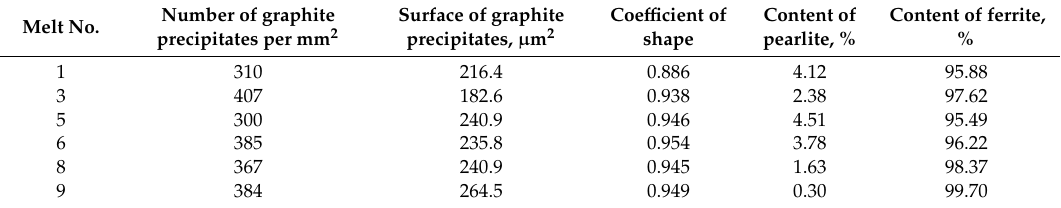
Table 5. Results of the quantitative analysis of the structure (average values).